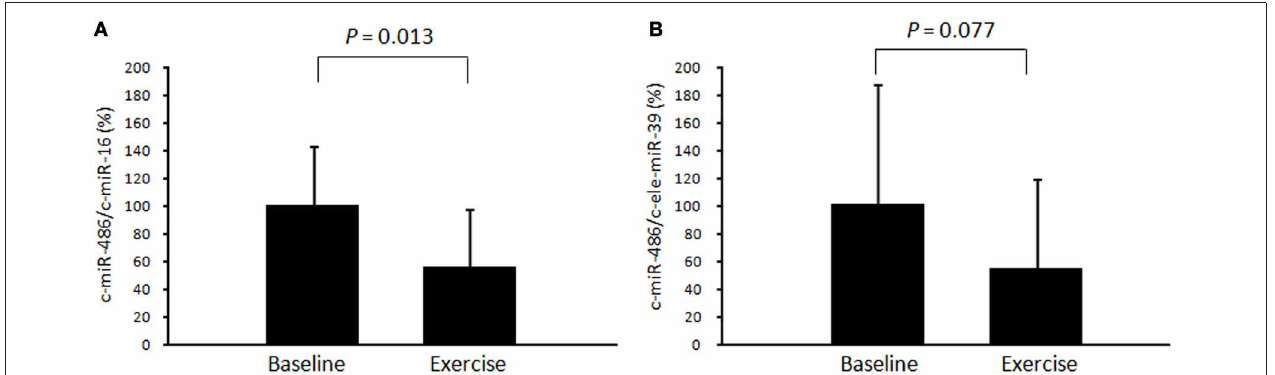
FIGURE 2 | Changes in circulating miR-486 in response to acute exercise. The level of circulating miR-486 in response to a single bout of exercise was determined. The ratio of the signal for miR-486 to that